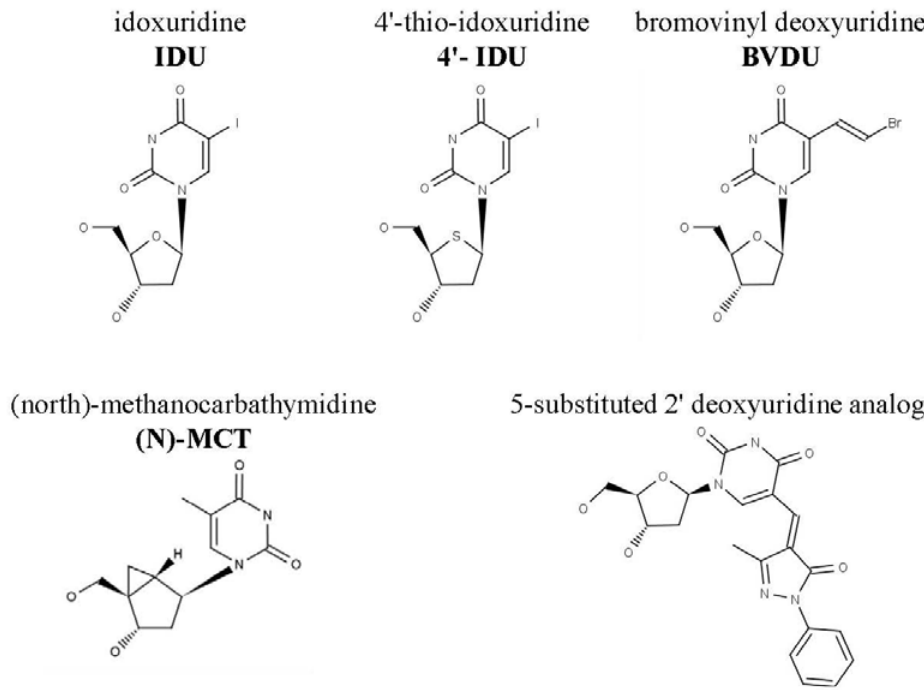
Figure 1. Structure of selected thymidine analogs. Structures of thymidine analogs are shown with abbreviations in bold text. The specific example of a 5-substituted deoxyuridine analog is